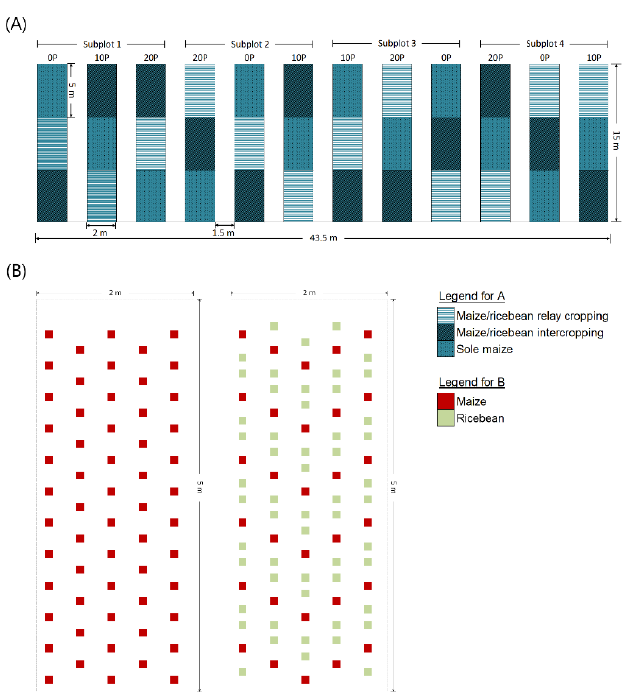
Figure 2. ( A ) Layout of the plot for the researcher-managed field trial (replicated in two positions on the slope of a hill). Each plot was divided into four sub-plots (four replicates), which were further divided into three blocks to represent three P fertilisation levels: 0 (0P), 10 (10P) and 20 (20P) kg P ha -1 . Each block consisted of three sub-blocks to represent the three different types of cropping systems. ( B ) Design of the sub-blocks for (i) sole maize and (ii) maize/ricebean intercropping and relay cropping systems.